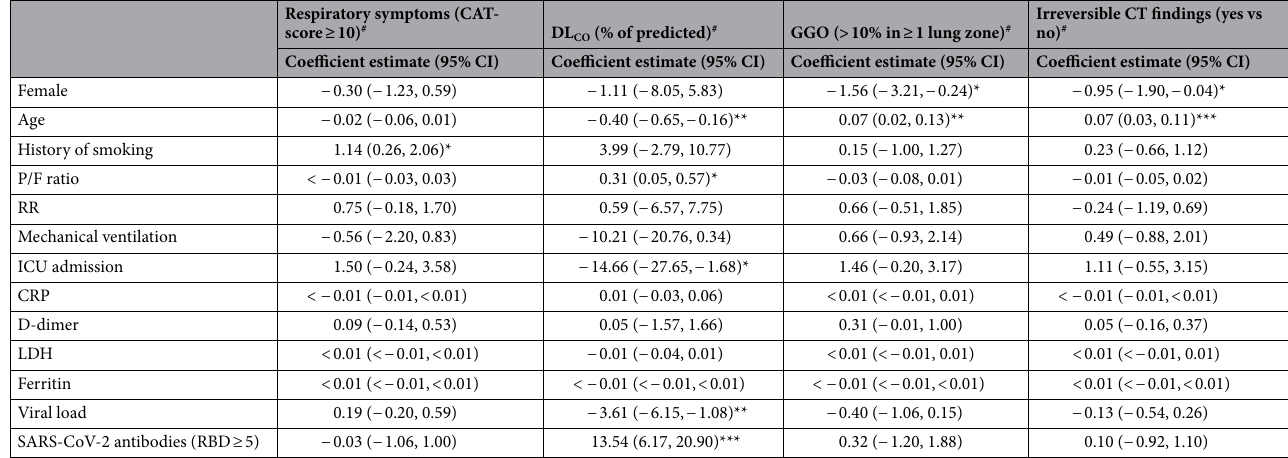
Table 4. Association of respiratory symptoms, DL CO , ground glass opacities, and irreversible CT-findings, with clinical and demographic characteristics during hospital admission. Main effect linear logistic regression analyses, adjusted for treatment, sex, age, and history of smoking. Biochemical markers are baseline values. Irreversible CT findings defined as any finding of parenchymal bands, consolidations, reticular pattern, or interlobular septal thickening. DL CO diffusion capacity of the lungs for carbon monoxide, CAT score the COPD Assessment Test score, RR respiratory rate, p/f ratio pO2/FiO2 ratio, ICU intensive care unit, CRP C-reactive protein, LDH lactate dehydrogenase, RBD receptor binding domain, GGO ground glass opacities, CT computed tomography. *p < 0.05, **p < 0.01, ***p < 0.001. # Dependent variable.